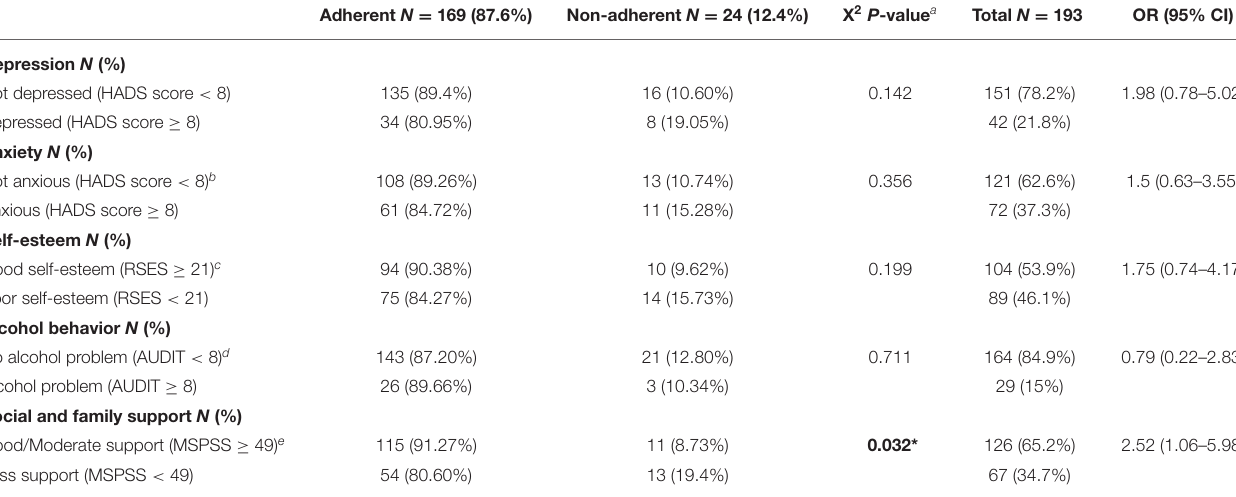
TABLE 2 | Prevalence and associations between depression, anxiety, self-esteem alcohol misuse, and social family support and ART adherence. Adherent N = 169